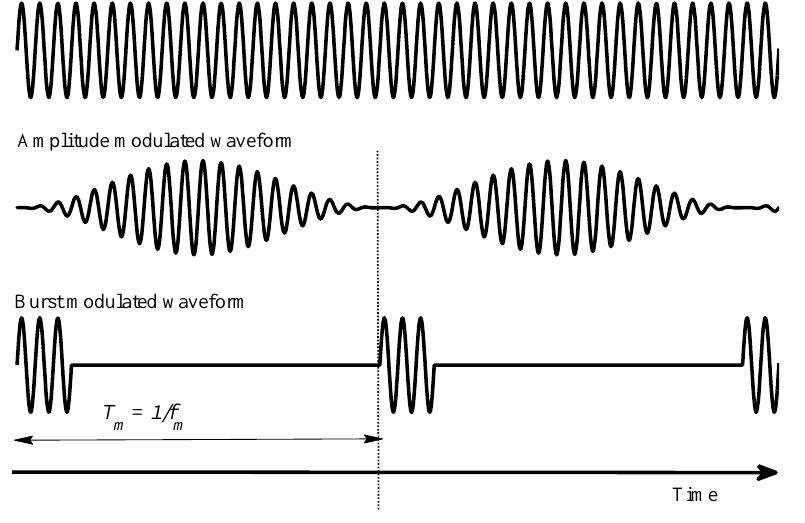
Figure 5. Different input waveforms having the same carrier frequency of the actuator. The definition of the modulation frequency f m is also shown for modulated